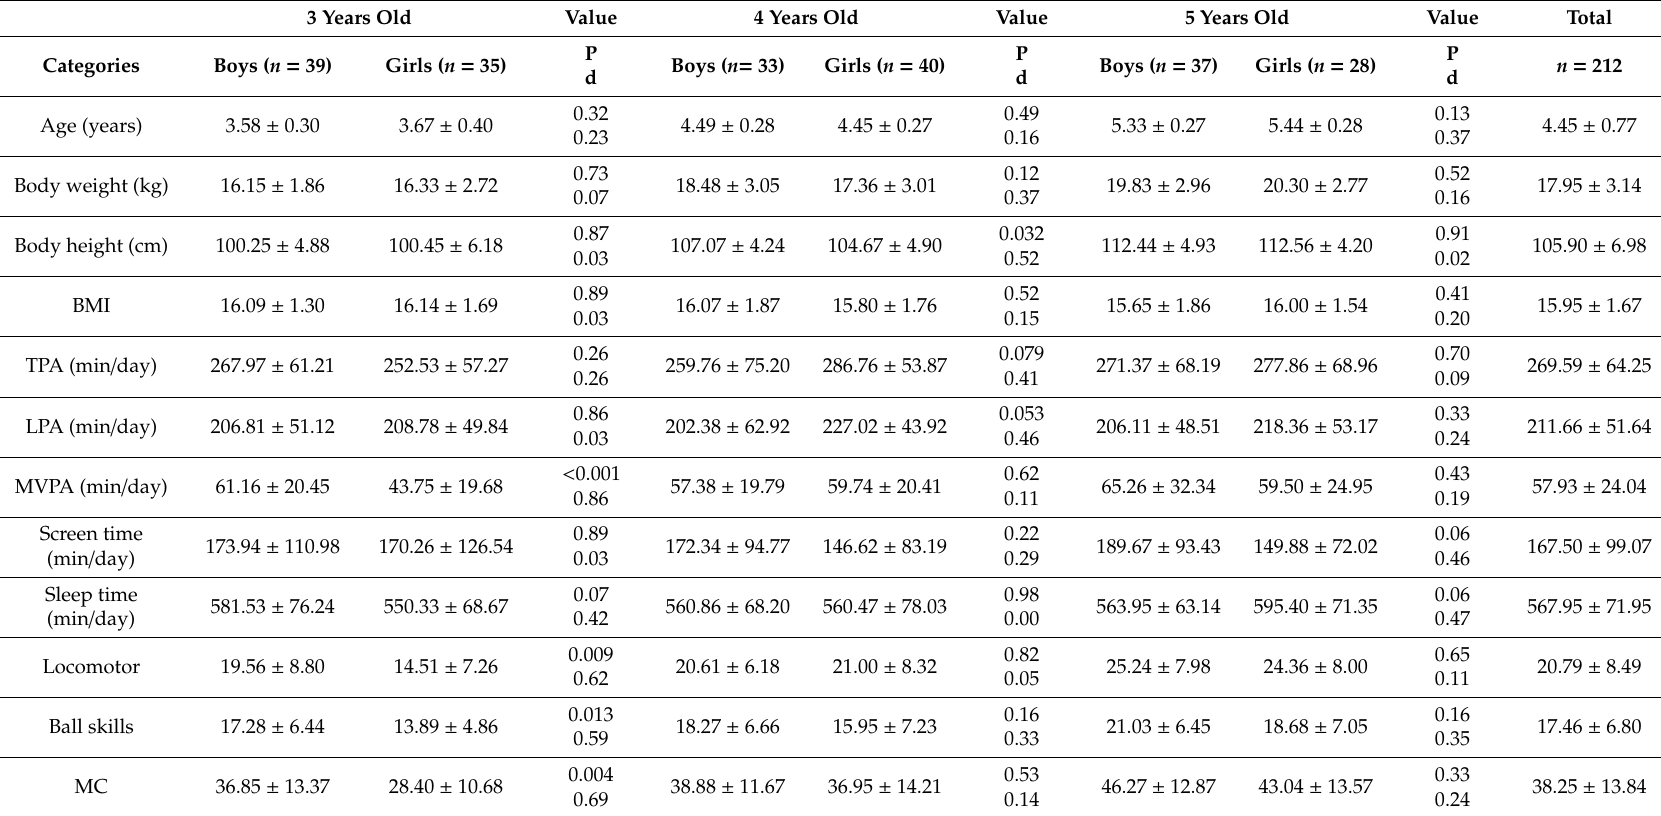
Table 1. Sample characteristics and di ff erences by age and